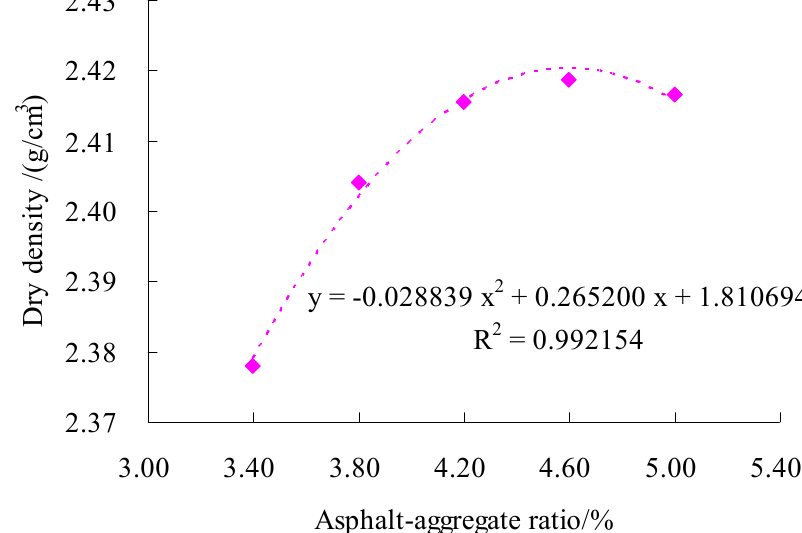
Figure 7. Test results of dry density at different asphalt–aggregate ratios.